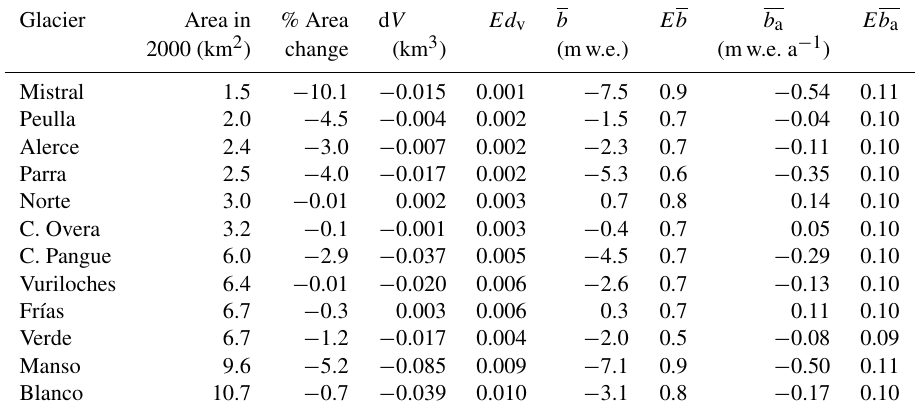
Table 4. Area, volume and mass balance change of Monte Tronador glaciers (2000–2012), with their corresponding error estimation. See Appendix A for a detailed description of these